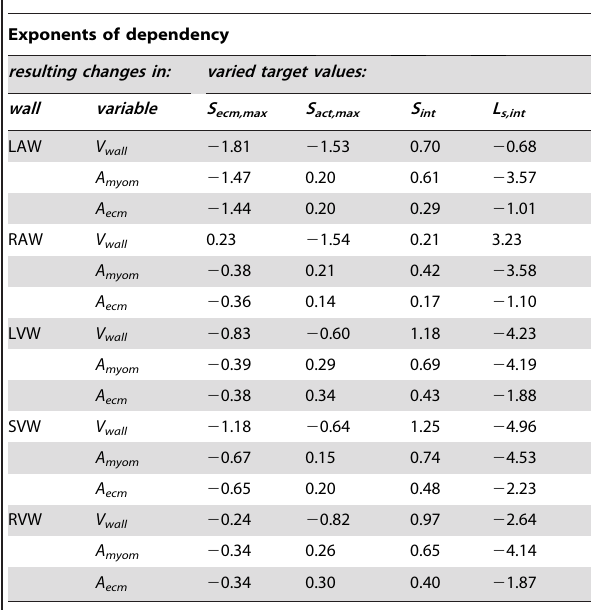
Table 5. Sensitivity of steady state geometry to changes in target